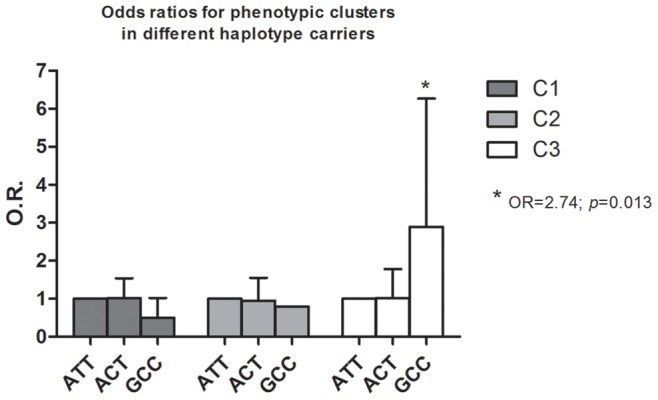
Results of risk analysis of haplotype carrying in different phenotypic clusters.Allelic components of the presented haplotypes are rs3787138, rs1044396 and rs3787140 SNPs, respectively. OR, odds ratio.